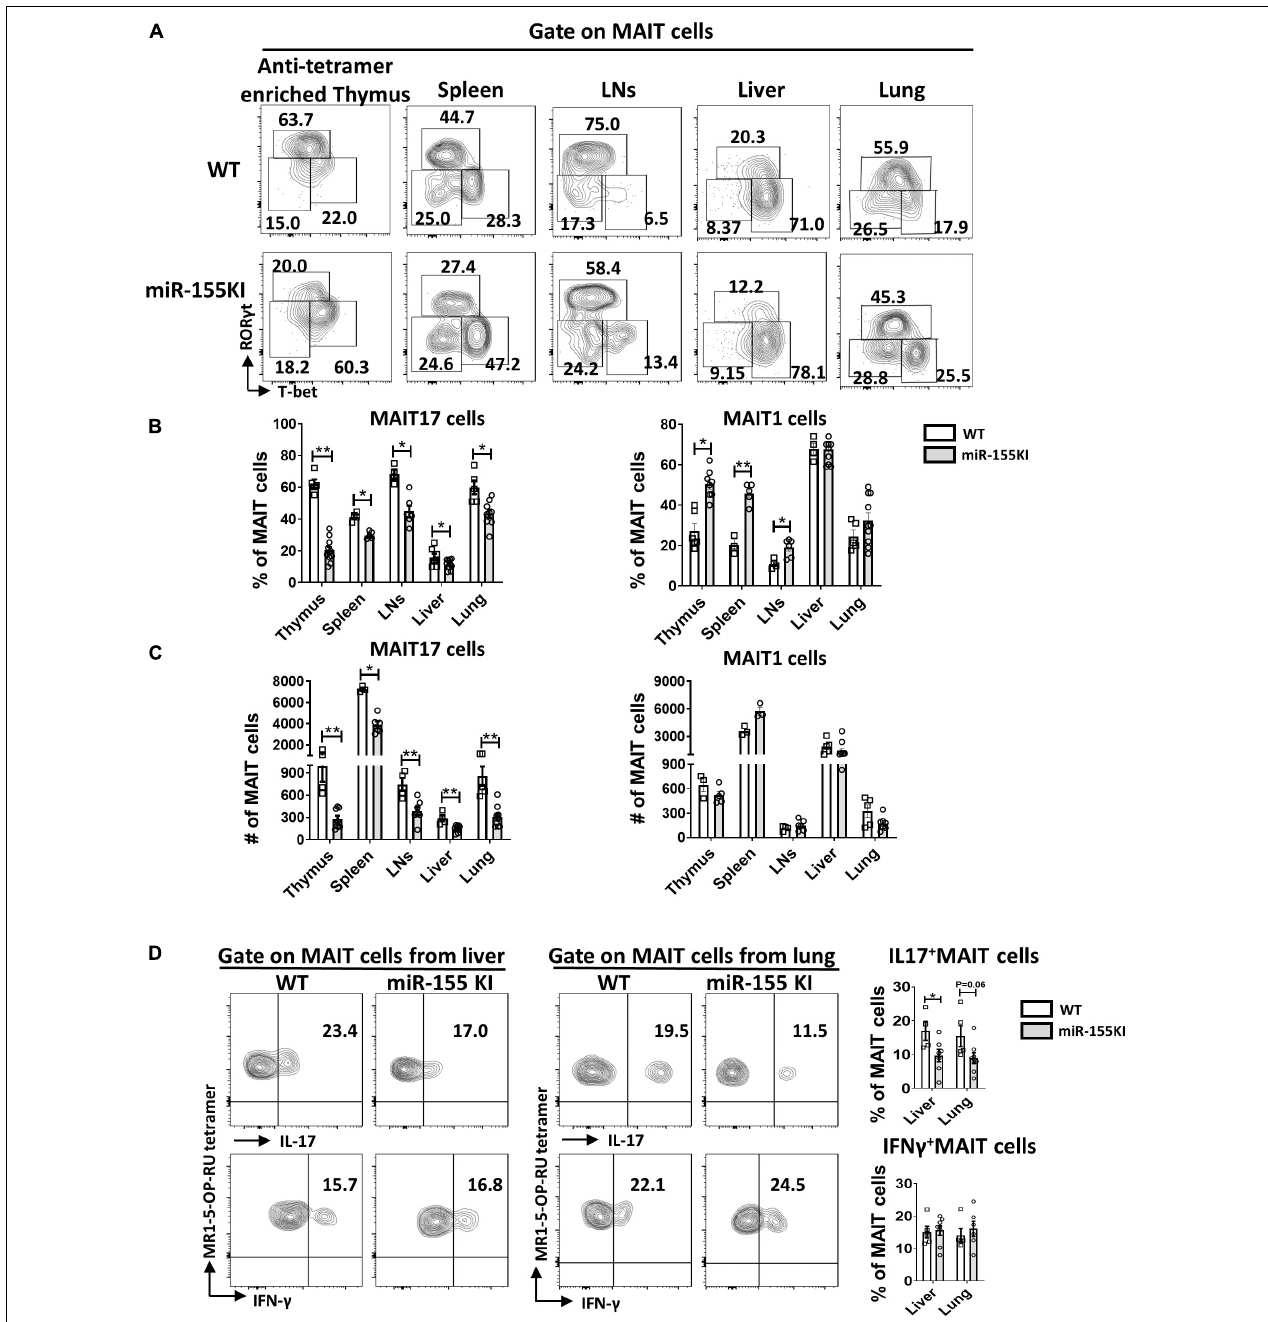
FIGURE 3 | miR-155 overexpression regulates MAIT 1 and MAIT17 differentiation. (A) Expression of transcription factors in thymus and peripheral organs of MAIT cells from WT and miR-155 KI mice examined by intracellular staining of ROR γ t and T-bet. MAIT17 cells are defined as ROR γ t + T-bet − subsets and MAIT1 cells are defined as ROR γ t − T-bet + subsets. Numbers adjacent to outlined areas indicate percentage of indicated populations. (B) The percentage and (C) absolute number of MAIT17 and MAIT1 cells in thymus and peripheral organs. (D) IL-17 and IFN- γ production of MAIT cells from liver and lung in miR-155 KI mice. Data are from at least two independent experiments. Each mouse is represented as one dot. 3–8 mice for each group. Data were analyzed by unpaired t -test. * p < 0.05, ** p < 0.01 compared to